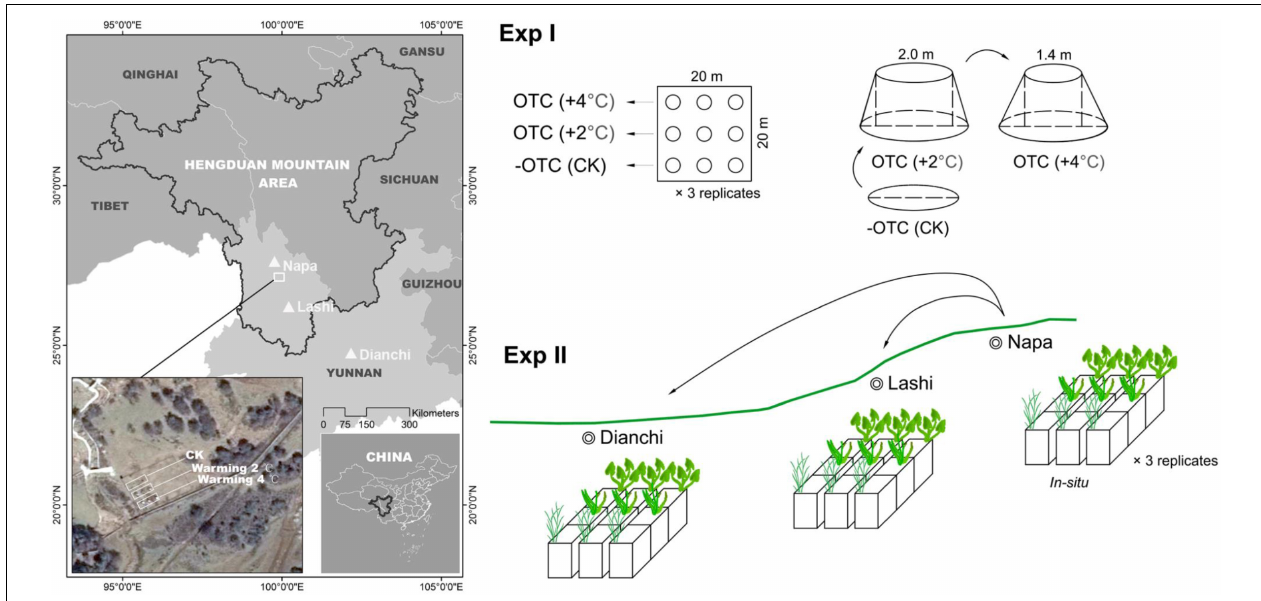
FIGURE 1 | Warming experiments used in this study. Experiment I (Exp I): field warming manipulations using open-top chambers (OTCs). Two types of OTCs were used, differing in the sizes of the open window at the top (2.0 m and 1.4 m diameter) to achieve two warming targets of +2 ◦ C and +4 ◦ C, respectively. The ambient conditions were simulated in the open air without using OTC (CK, as the control). The chambers were set up in a fenced plot (20 m × 20 m) in Shangri-La Research Station, Northwest Yunnan Plateau. Experiment II (Exp II): field transplant experiment using a natural latitudinal gradient. Plants and their soil were transplanted together from the origin (Napa, 3260 m in elevation) to two lower sites (Lashi, 2400 m and Dianchi, 1980 m).